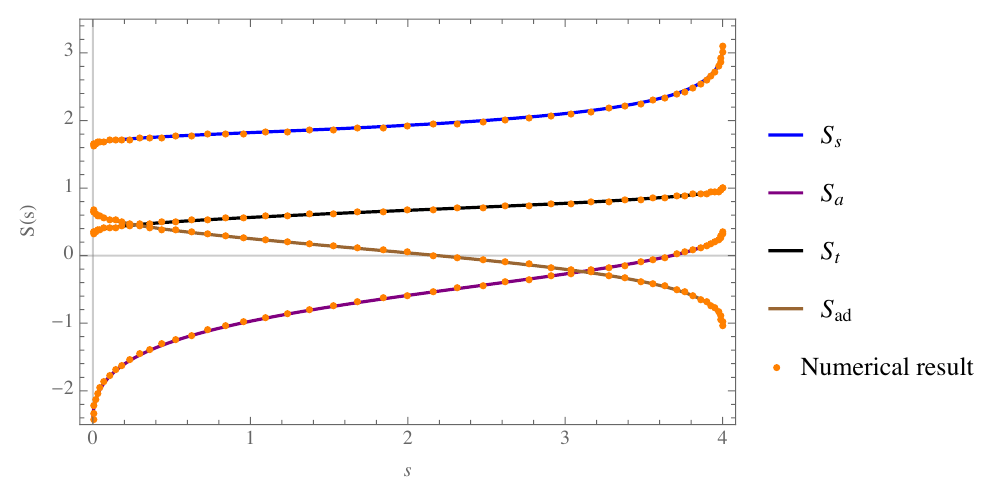
Figure 8 . Comparison of the numerical S -matrix with the SU(3) Gross-Neveu model S -matrix. We have subtracted the pole structure in S ( s ).